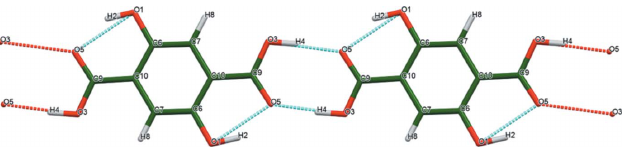
Figure 5 The hydrogen bonds in the structure of anhydrous 2,5-dihydroxy- terephthalic acid. Image generated using Mercury (Macrae et al. , 2020).